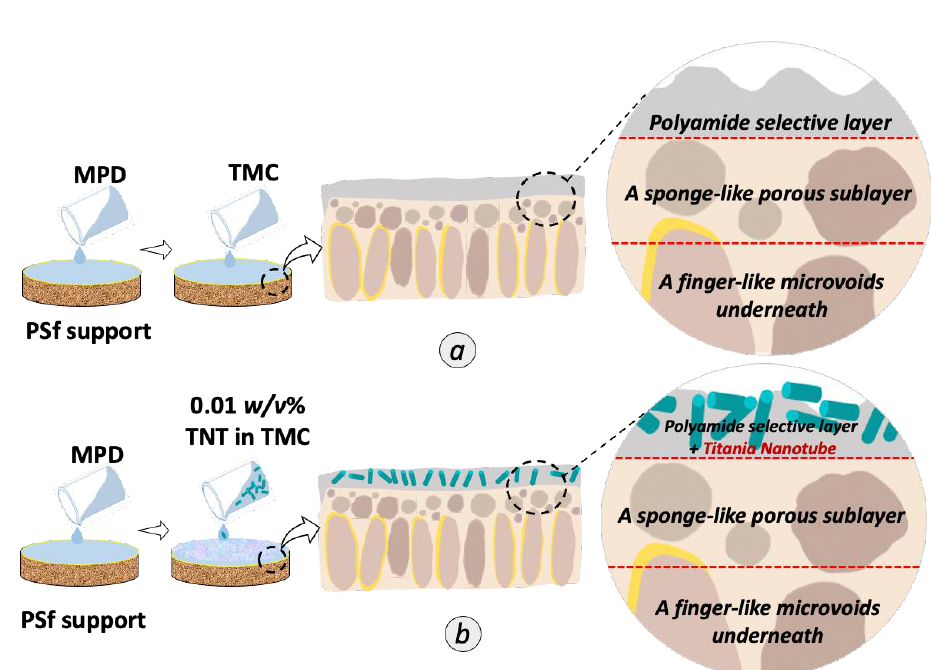
Figure 1. Schematic illustration of the preparation of ( a ) TFC and ( b ) TFN membranes incorporated with randomly aligned TNT in the PA selective layer.